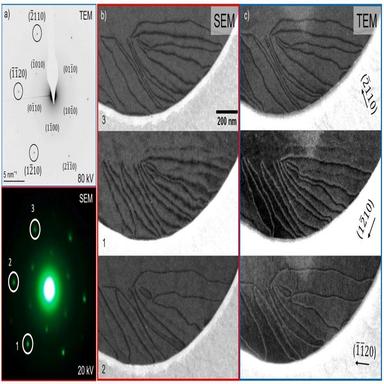
Comparison between aperture-based dark-field STEM imaging in SEM (red frames, 20 kV) and conventional dark-field imaging in TEM (blue frames, 80 kV). a) Diffraction patterns recorded in both instruments. The contrast of the TEM diffraction pattern is inverted for better visibility of the diffraction spots. For SEM only the field-free mode is shown (cf. 2). b-c) Dark-field images of the same area, recorded in the SEM (left) and in the TEM (right). The three selected reflections g are marked in th